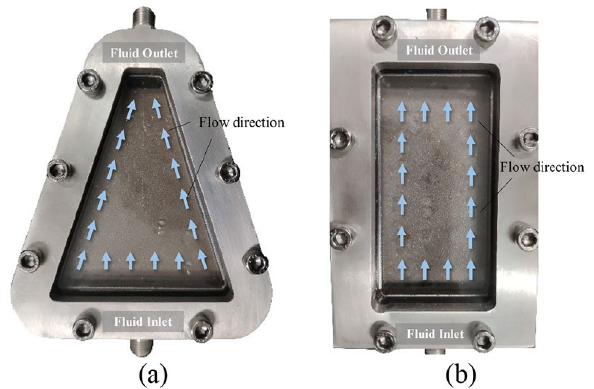
Fig. 3 The trapezoidal and rectangular sandstone models. a The trap- ezoidal simulation model and b the rectangular simulation